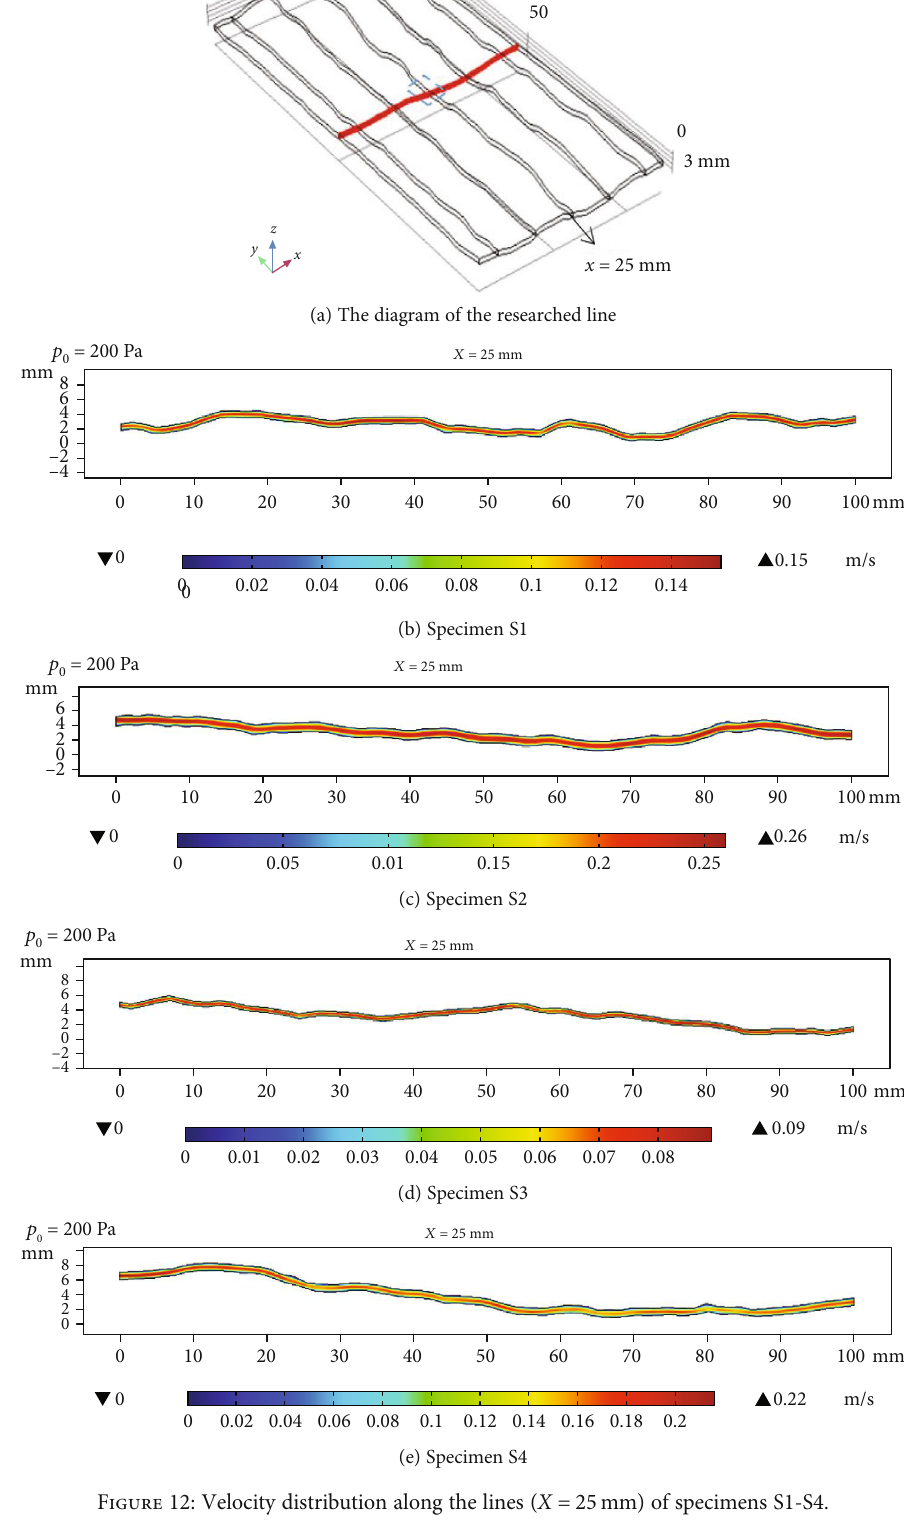
Figure 12: Velocity distribution along the lines ( X = 25mm ) of specimens